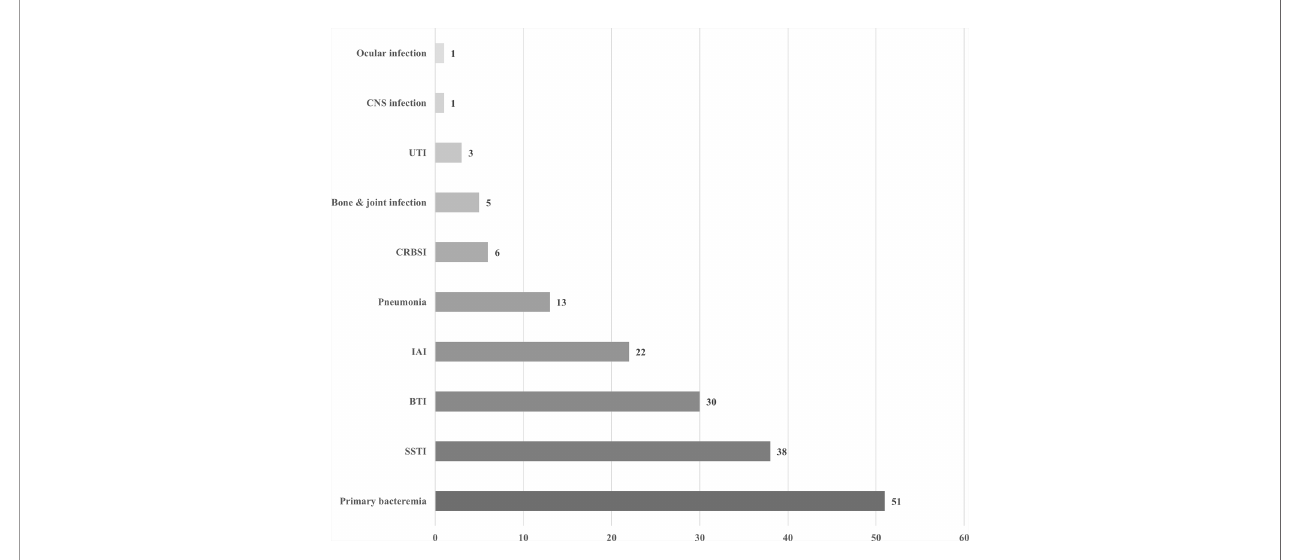
FIGURE 1 | Clinical manifestations of 164 episodes of Aeromonas infection. UTI, urinary tract infection; CRBSI, catheter-related bloodstream infection; IAI, intra- abdominal infection; BTI, biliary tract infection; SSTI, skin and soft tissue infection.